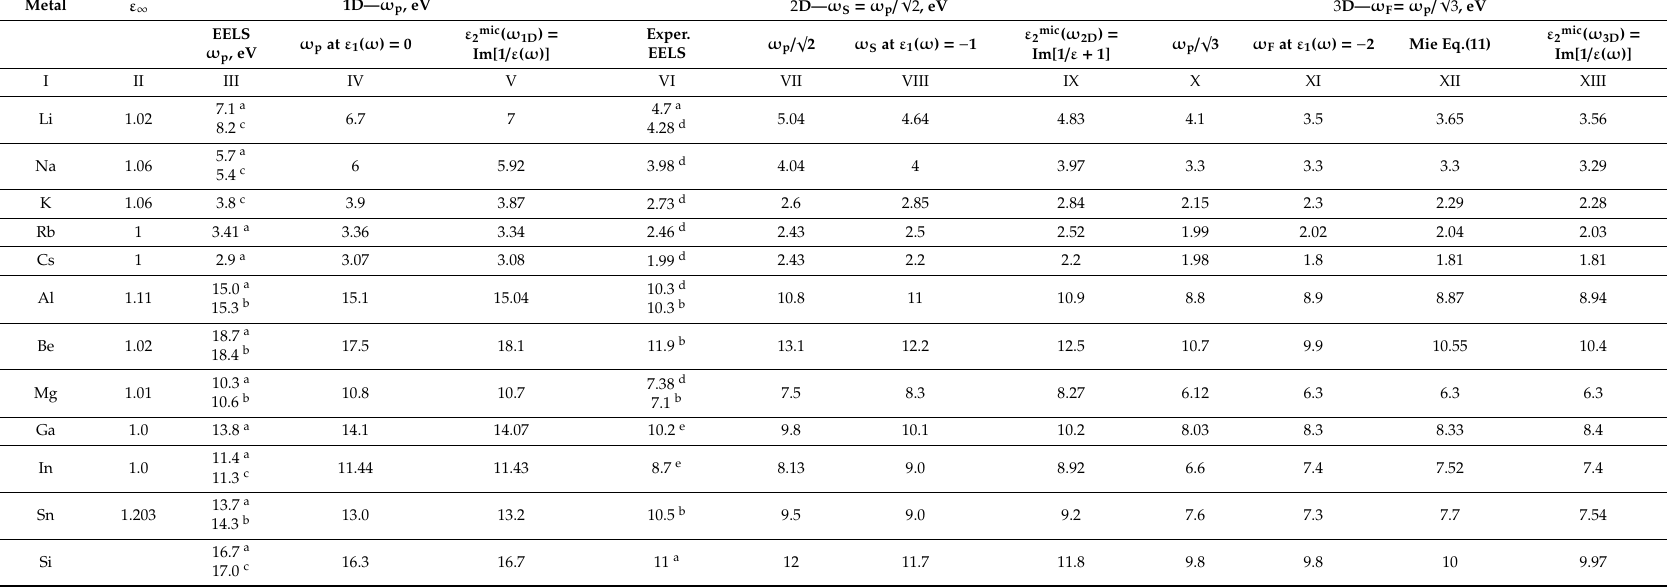
Table 1. Calculated and experimental peak positions of ε 2 mic ( ω mD ) spectra calculated for 1D ( m = 1), 2D ( m = 2) and 3D ( m = 3) confinement and experimental data for the bulk ( ω p ) and surface ( ω s )